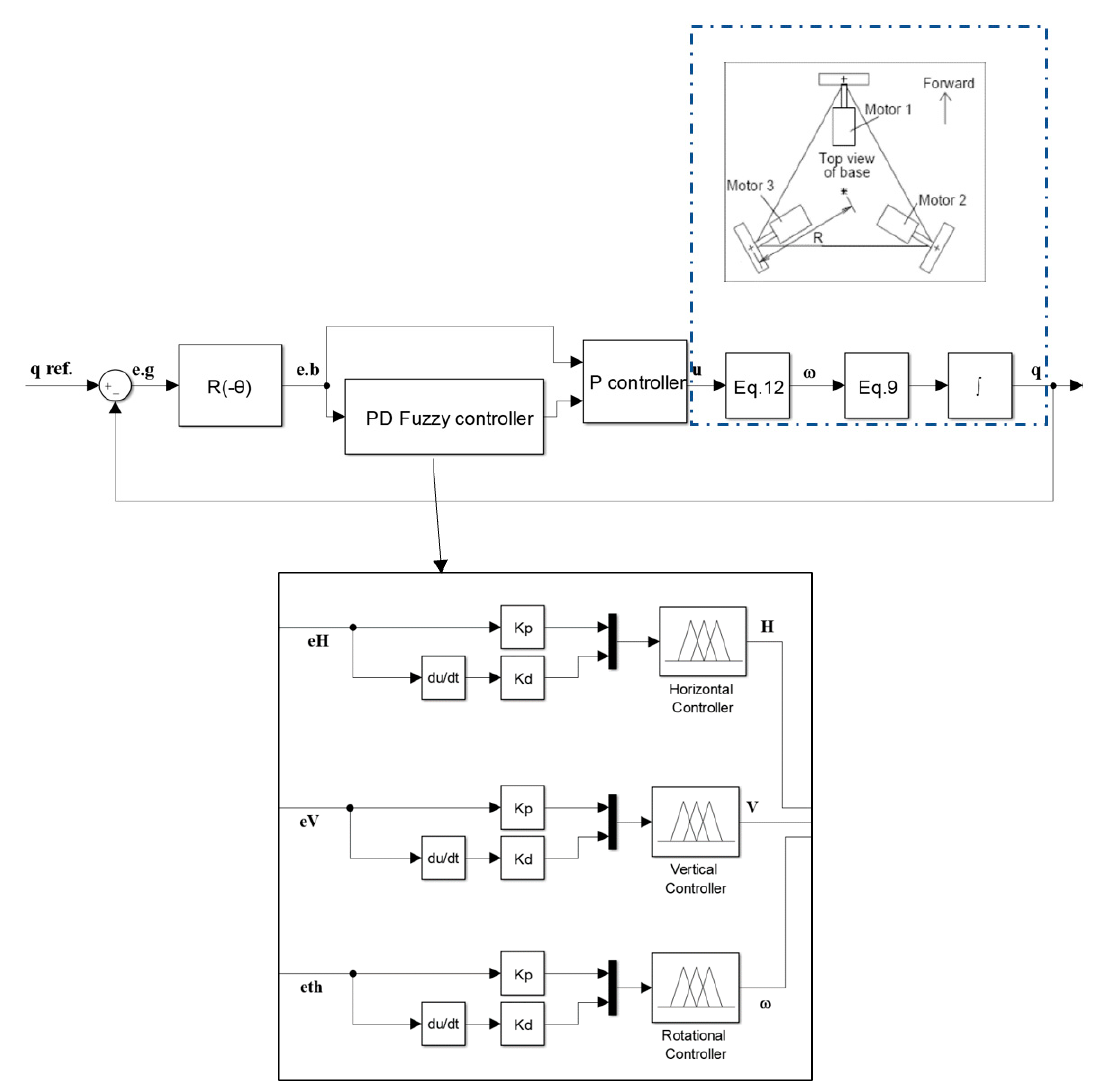
Figure 4. PD-Fuzzy-P controller using decentralize algorithm.